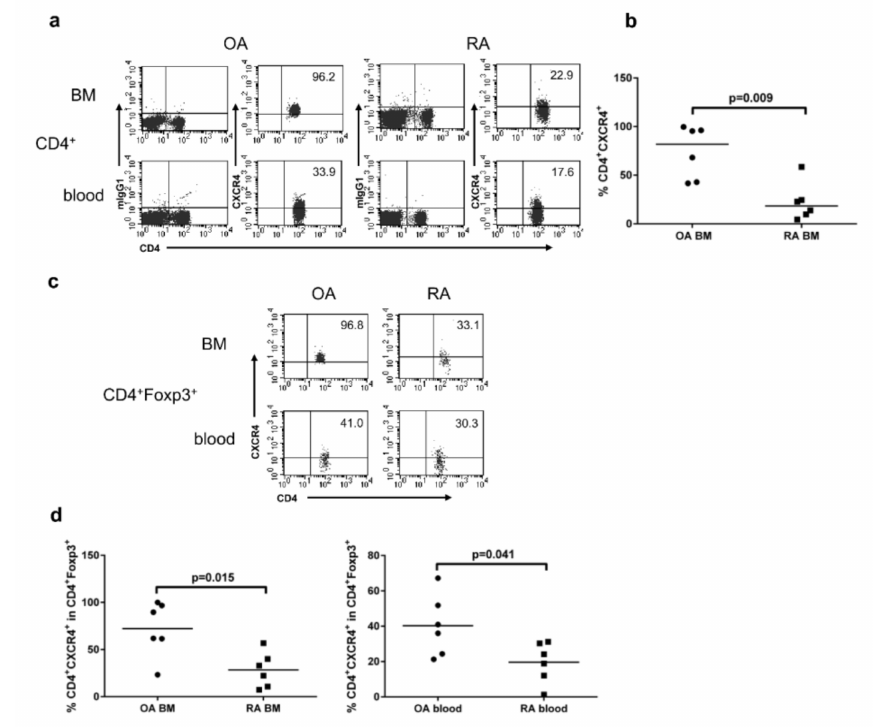
Figure 3. Expression of CXCR4 by CD4 + and CD4 + FOXP3 + cells from the bone marrow and peripheral blood of OA and RA patients. ( a ) Representative dot plots show CXCR4 expression by gated CD4 + cells in the BM and peripheral blood of the same patient. ( b ) CXCR4 expression by CD4 + T cells in OA and RA BM. ( c ) Representative dot plots show CXCR4 expression by gated CD4 + FOXP3 + regulatory T cells (Tregs) in the BM and peripheral blood of the same patient. ( d ) CXCR4 expression by gated CD4 + FOXP3 + Tregs in the BM (chart on the left) and peripheral blood (chart on the right) of OA and RA patients. In all the cases, di ff erences between groups of patients were analyzed by Mann–Whitney U-test. Numbers depicted on dot plots show the frequencies of subset expressing CXCR4. Individual results are shown as dots and median as a bar on charts ( n = 6 subjects per group). OA / RA BM / blood—cells isolated from the BM / peripheral blood of patients with OA / RA,